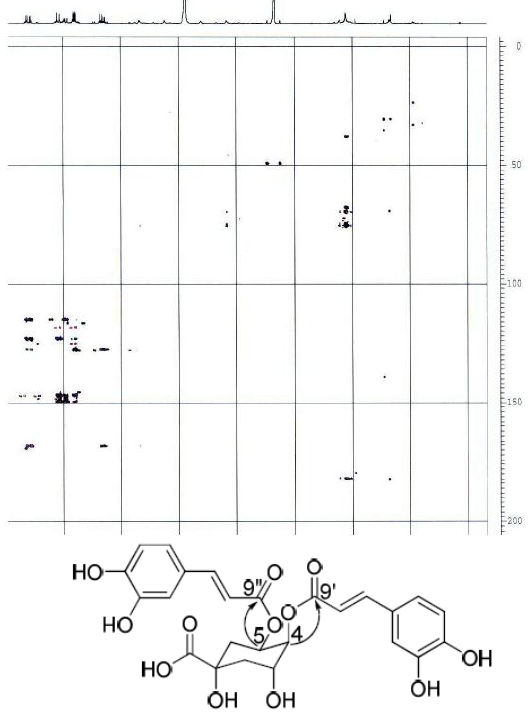
Figure 6. HMBC spectrum of compound 3